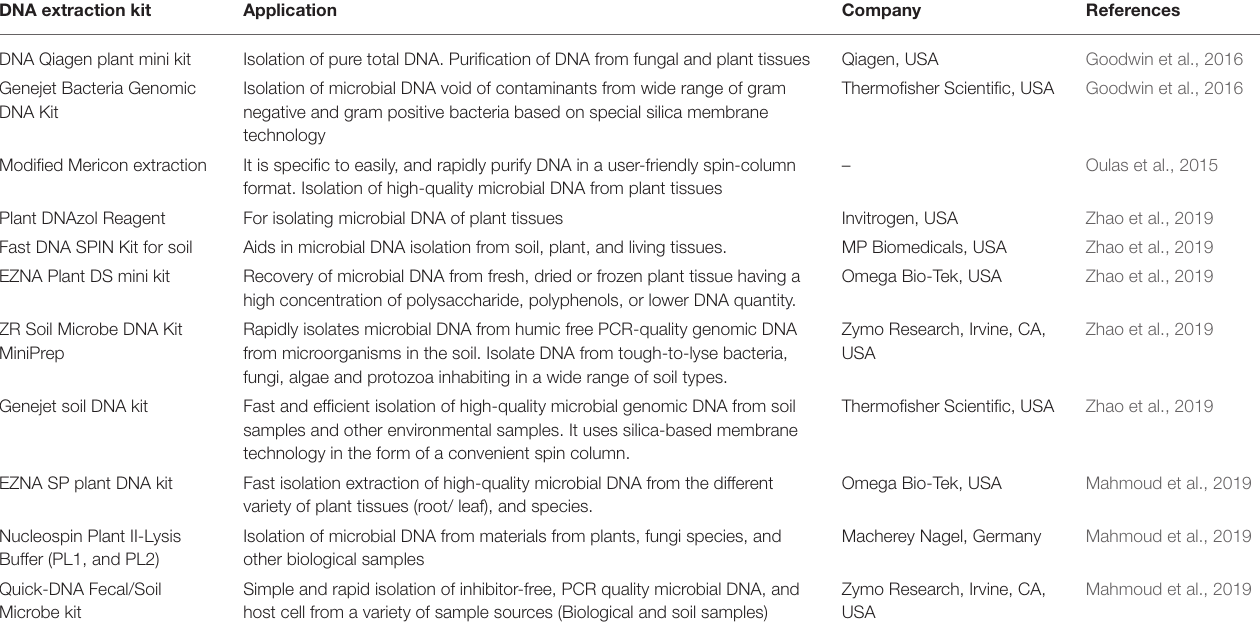
TABLE 1 | Widely used DNA extraction kit for identifying rhizospheric microorganisms.